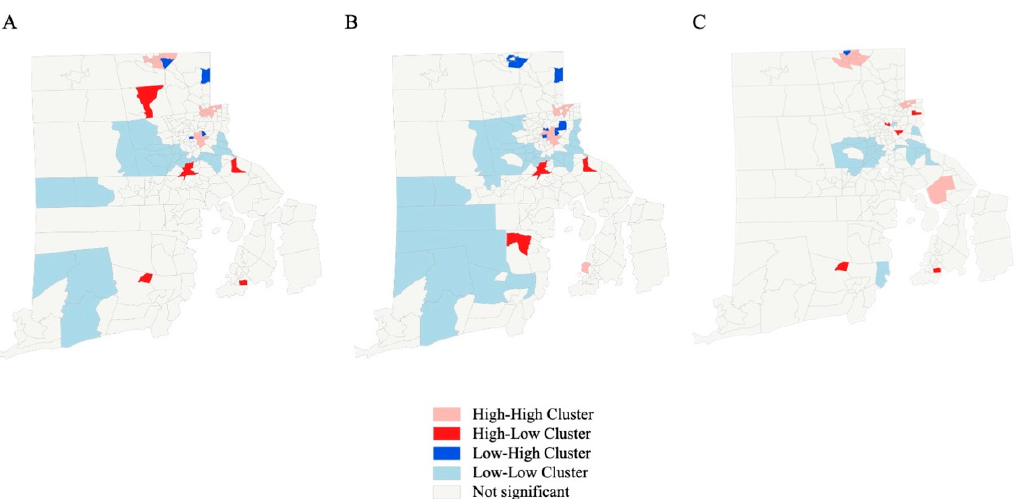
Figure 3. Local indicators of spatial association (LISA) for rates of ambulance calls due to suspected infectious diseases in the pediatric population on a census tract basis. ( A ), Entire observation period. ( B ), Before the beginning of the COVID-19 pandemic. ( C ), After the beginning of the COVID-19 pandemic.